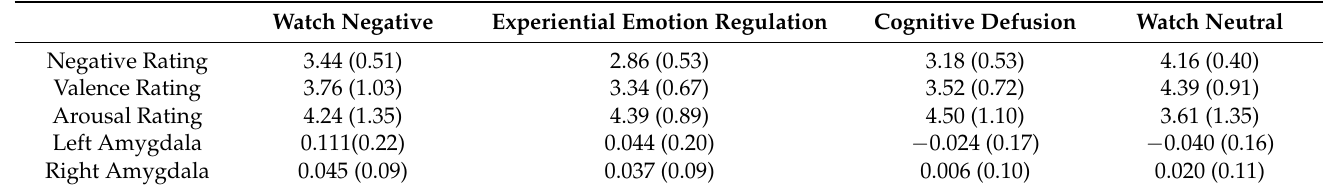
Table 1. Mean (SD) of subjective rating on the trial level, valence, and arousal rating on the ex- perimental condition level, as well as the signal change of bilateral amygdala on the experimental condition level.